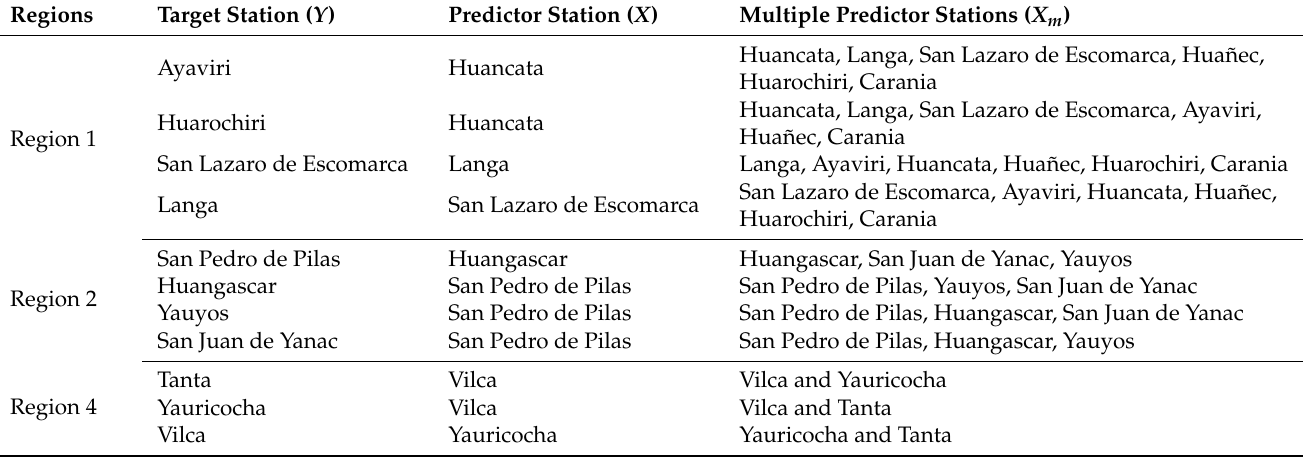
Table 5. Identification of target stations ( Y ) and predictor stations by homogenous